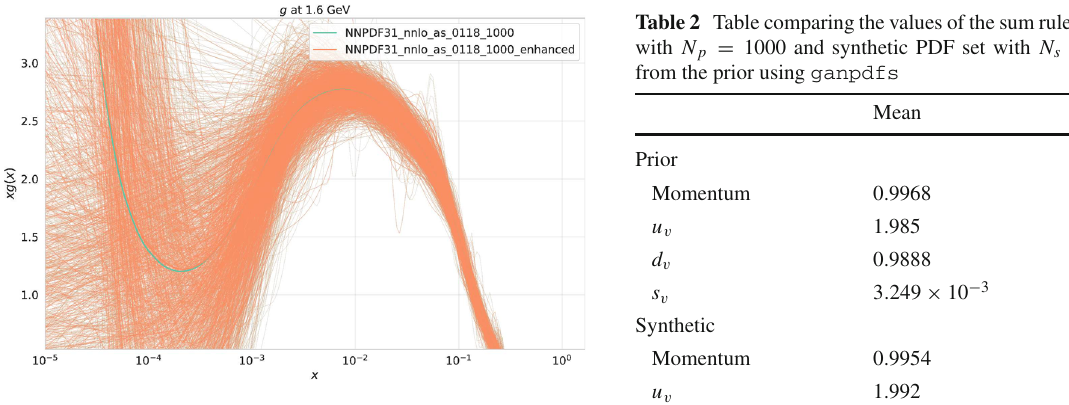
Fig. 5 Comparison of the prior Monte Carlo PDF replicas with 1000 replicas and the synthetics with 2000 replicas generated from the prior.